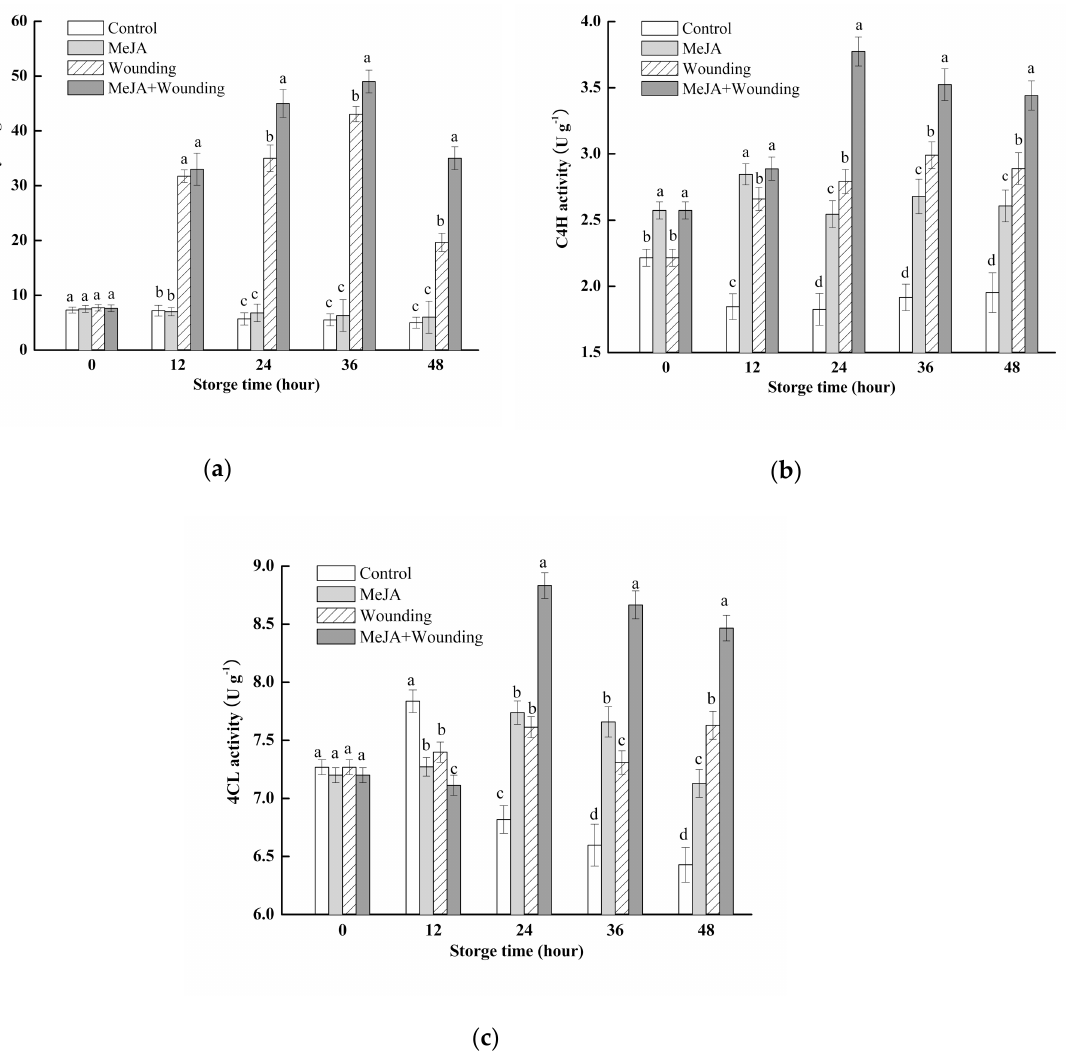
Figure 5. Effect of MeJA treatment and wounding stress on the activities of PAL ( a ), C4H ( b ), 4CL ( c ) of broccoli during 48 h of storage at 20 °C. Columns with vertical bars represent the mean ±SD ( n = 3).